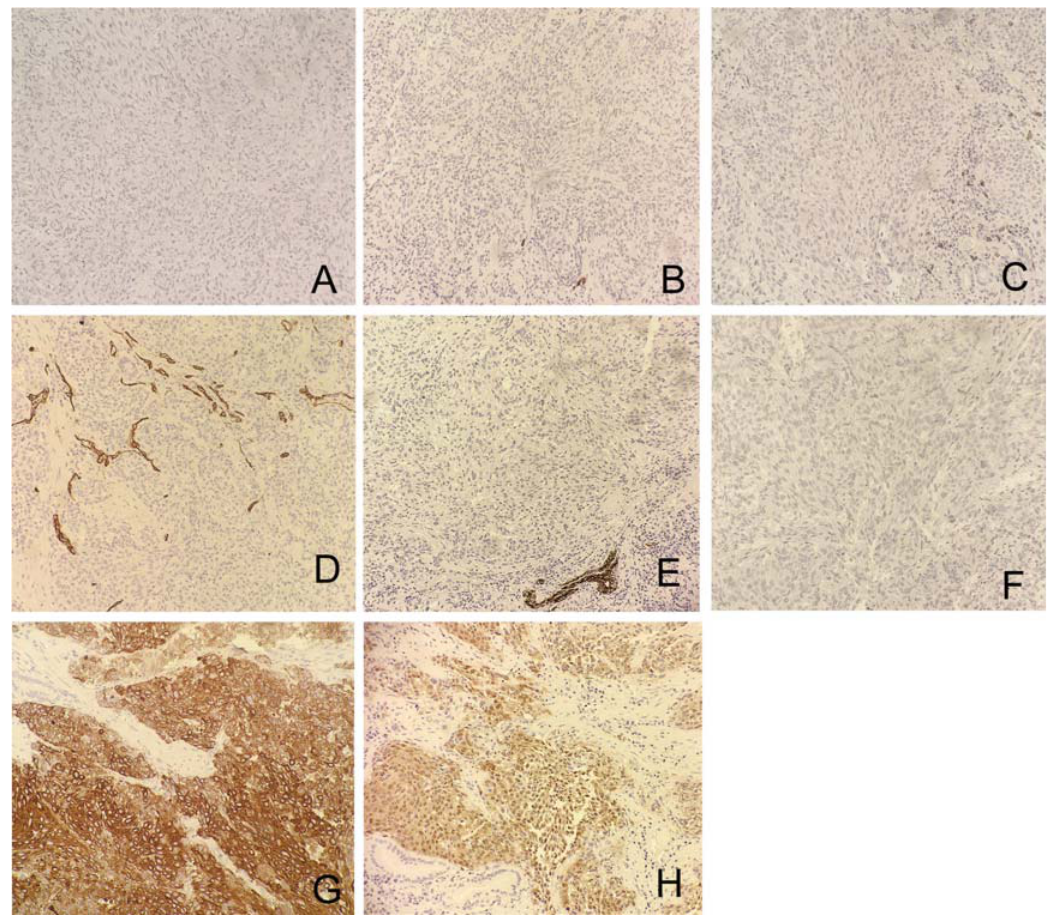
FIGURE 2. Immunohistochemical profi le of the tumor. Chromogranin-A, CD56, CD117, CD34, CK7 and CK20 were negative (A, B, C, D, E and F, respectively). CK5/6 and p16 were strongly positive (G and H, respectively). CK: